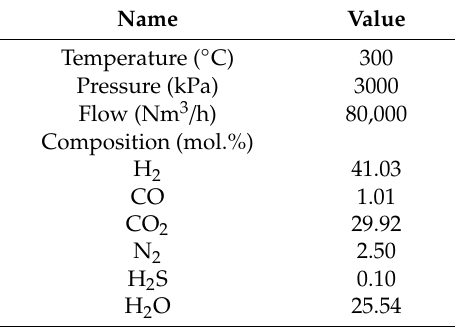
Table 2. Feed condition and